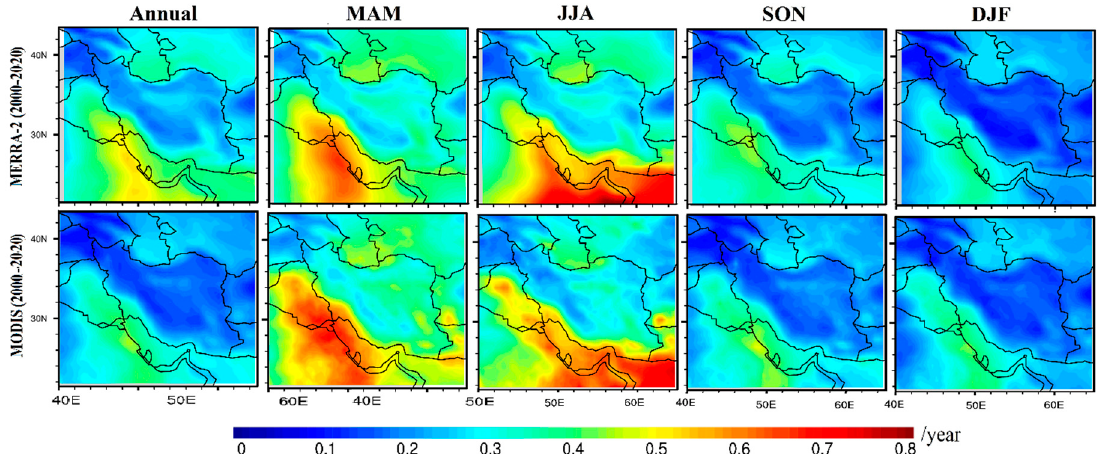
Figure 2. Spatial distributions of annual and seasonal mean AODs from MERRA-2 and MODIS during the period 2000–2020.